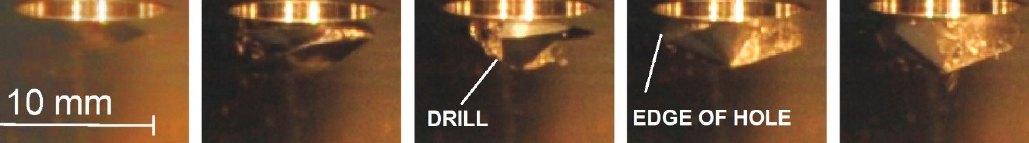
Figure 14. Camera frames showing subsequent stages of drilling with a factory drill. Figure 15. Camera frames showing subsequent stages of drilling with a modified drill.